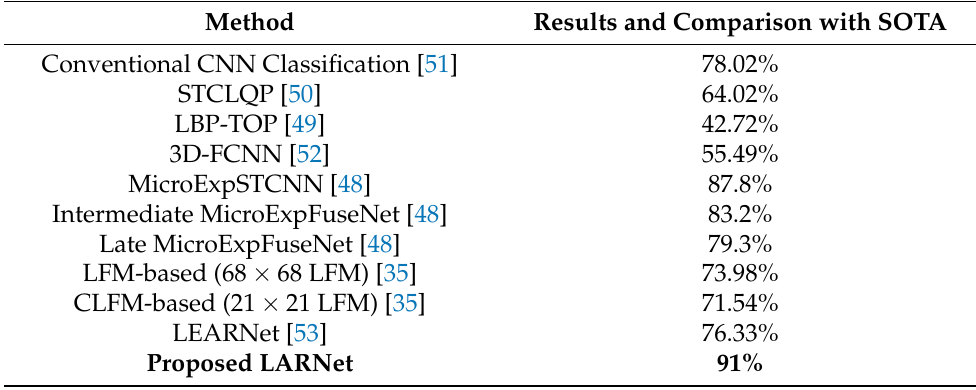
Table 5. LARNet compared with state-of-the-art methods trained on CAS(ME)2